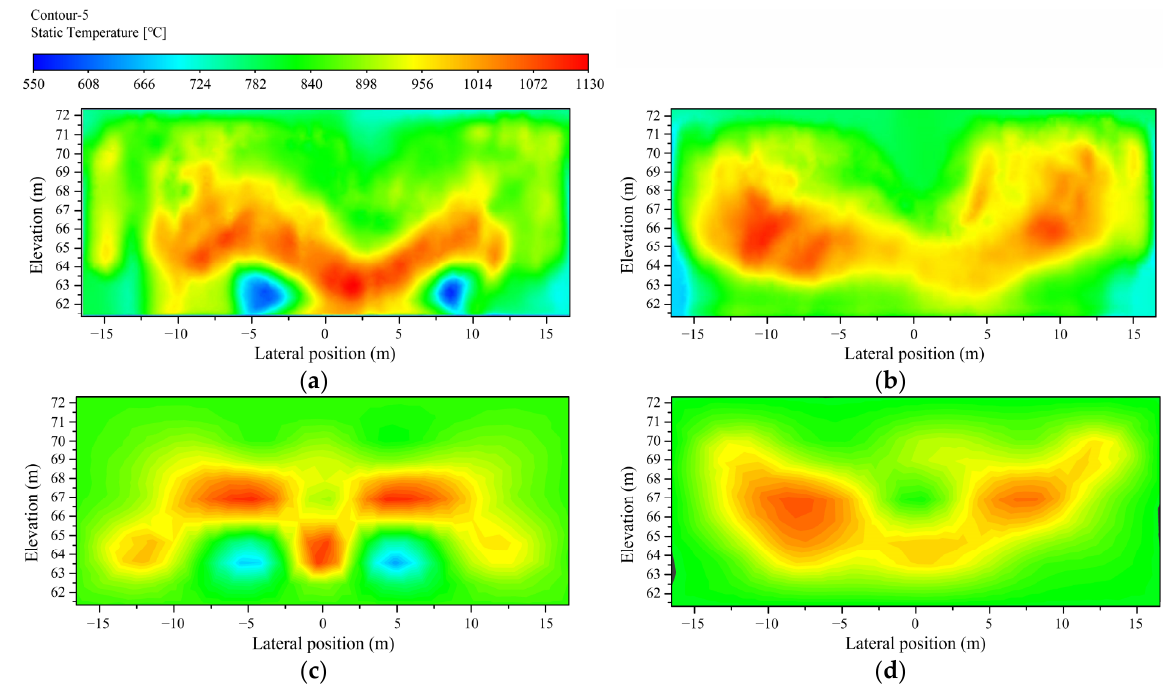
Figure 7. Numerical simulation results of flue gas temperature contours; ( a ) 100% load case; ( b ) 75% load case.